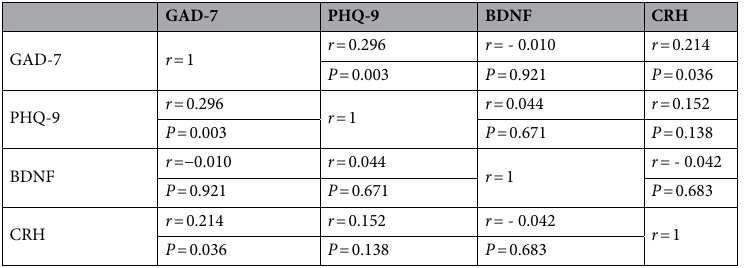
Table 4. Correlations between anxiety, depression scores, serum BDNF and CRH levels. r —Spearman correlation coefficient. P < 0.05 is significant. GAD-7—Generalized Anxiety Disorder 7-item Scale. PHQ-9—